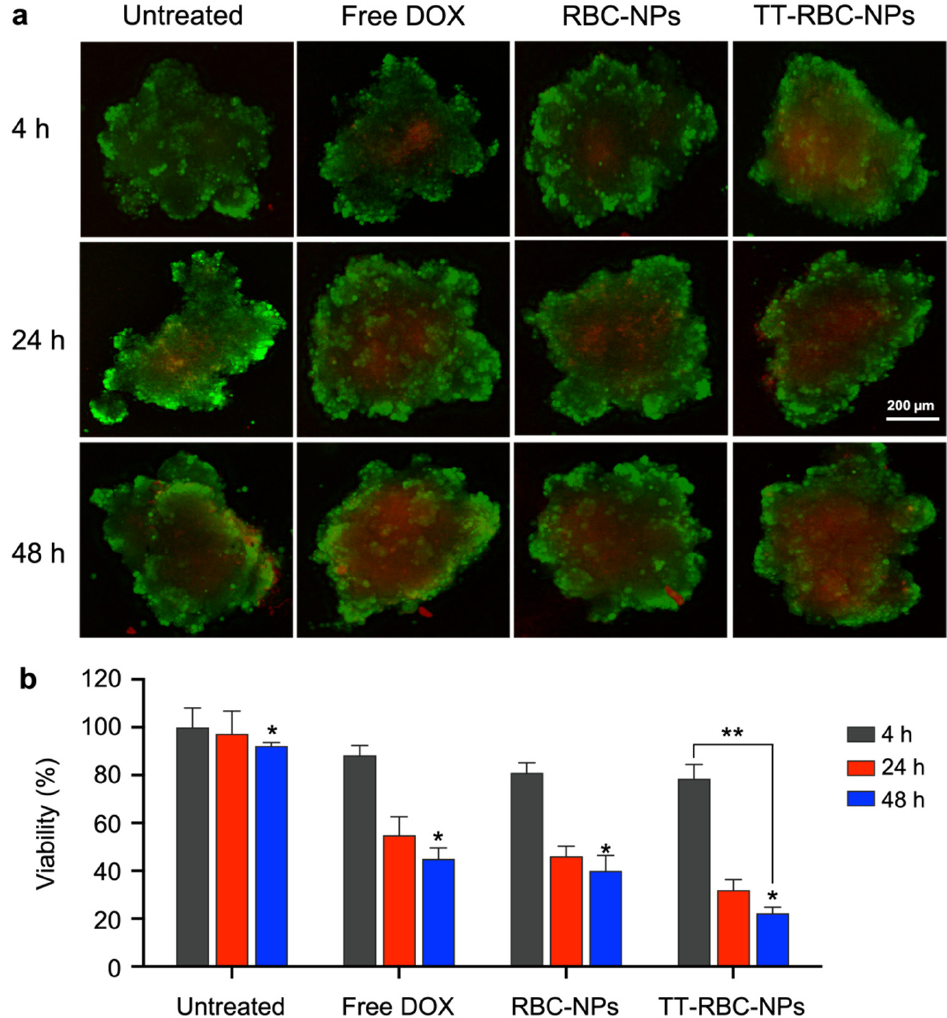
Figure 6. In vitro cellular toxicity of TT-RBC-NPs in three-dimensional (3D) spheroids. ( a ) In vitro live/dead cell imaging of tumor spheroid untreated, and treated with free DOX, RBC-NPs and TT-RBC-NPs (equivalent of 1 µ g/mL DOX) for a period of 4, 24 and 48 h. Two-color fluorescence, live (green channel) and dead (red channel), enables evaluation of live and dead cells to determine cell viability. Scale bar = 200 µ m. ( b ) In vitro cytotoxicity study using CellTiter-Glo ® 3D cell assay of untreated, free DOX, RBC-NPs and TT-RBC-NPs against 3D MCF-7 spheroids. Results represent mean ± SD ( n = 3). * the significance between Untreated, Free DOX, RBC-NPs, and TT-RBC-NPs at 48 h incubation ( p < 0.05). ** the significance between 4 h and 48 h incubation of TT-RBC-NPs ( p < 0.05).